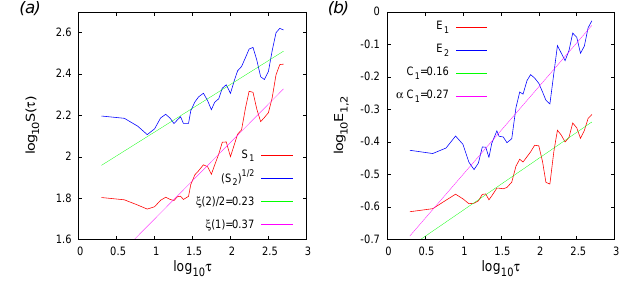
Figure 3. (a) Haar analysis on the detrended SIF data set for mo- ments q = 1 (red) and RMS (blue). ξ( 1 ) = ξ( 2 ) ≈ 0 at scales below 10–20nm, whereas for larger scales up to 500nm we have slopes ξ( 2 )/ 2 = 0 . 23 (green) and ξ( 1 ) = H = 0 . 37 (magenta). (b) Red: 1 log-log plot of E 1 = S 1 /(S 1 + δq /S 1 − δq ) 2 δq vs. τ whose slope is − 1 K (cid:48) ( 1 )( = C 1 ) , blue: log-log plot of E 2 = (S 1 + 2 δq S 1 − 2 δq /S 2 ) 4 δq 2 1 vs. τ whose slope is K (cid:48)(cid:48) ( 1 )( = αC 1 ) for δq = 0 . 1 (see Lovejoy and Schertzer, 2013, Ch. 10 for these estimators). The first yields an es- timate C 1 ≈ 0 . 16 indicating high intermittency, the ratio yields an estimate α = 1 . 7. For smaller scales (up to 10–20nm), the corre- sponding slopes are close to 0 indicating Gaussianity. With these parameters and Eq. (5) (i.e., the universal multifractal equation for K(q) in Sect. 2), we find ξ( 2 )/ 2 = H − K( 2 )/ 2 ≈ 0 . 37 − 0 . 14 = 0 . 23 in agreement with the direct estimate in Panel (a) .